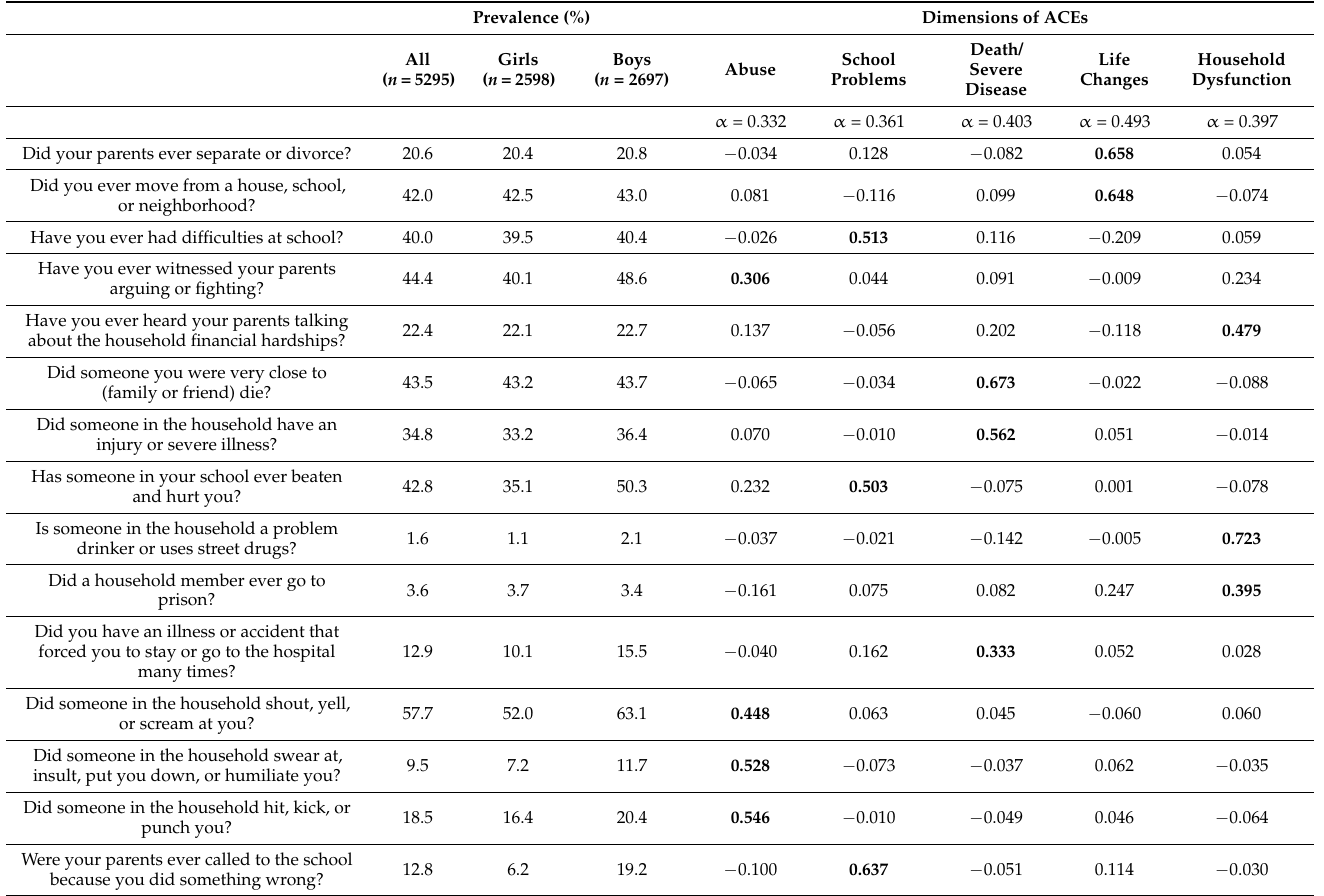
Table 1. Prevalence of adverse childhood experiences (ACEs) at 10 years of age according to the child’s sex, and eigenvector values for the five dimensions of ACEs in Generation XXI ( n = 5295). Prevalence (%) Dimensions of ACEs Death/ All Girls Boys School Life Household Severe ( n =5295) ( n =2598) ( n = 2697) Abuse Problems Changes Dysfunction Disease α = 0.332 α = 0.361 α = 0.403 α = 0.493 α =